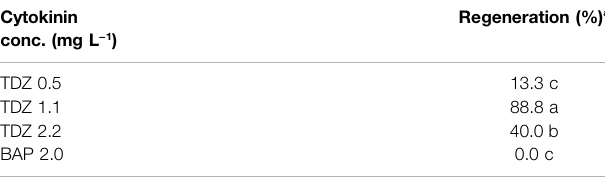
TABLE 6 | Effect of cytokinin in SIM medium on shoot regeneration of fi eld cress.